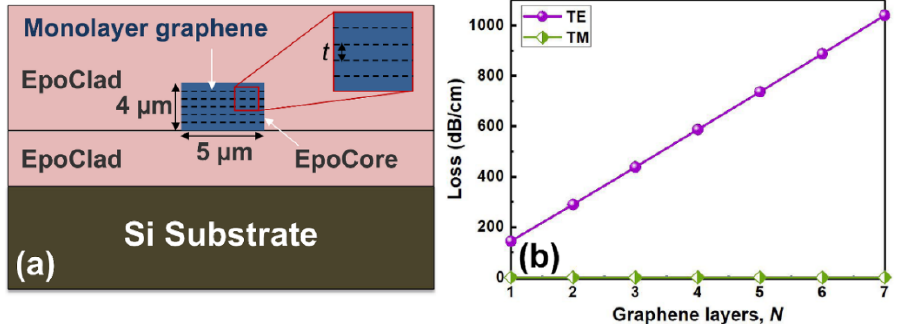
Figure 8. ( a ) The schematic diagram of the polarizer with different layers of graphene buried in the center of core layer and ( b ) the variation of the graphene-induced losses with the number of graphene layers.